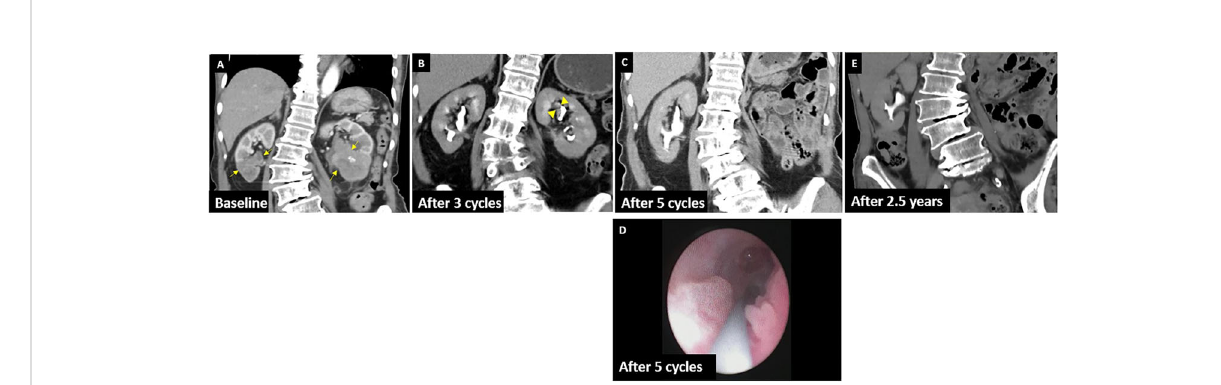
FIGURE 1 CTU of case 1. (A) Baseline: arrows show the UC in the bilateral renal pelvis with parenchyma invasion. (B) After three cycles: arrowheads show a residual tumor in the left upper calyx. (C) CTU revealed no recurrence after fi ve cycles. (D) Showing a suspected lesion at the right middle ureter in URS with dysplasia in the pathology report. (E) CTU revealed no recurrence in the latest follow-up (January